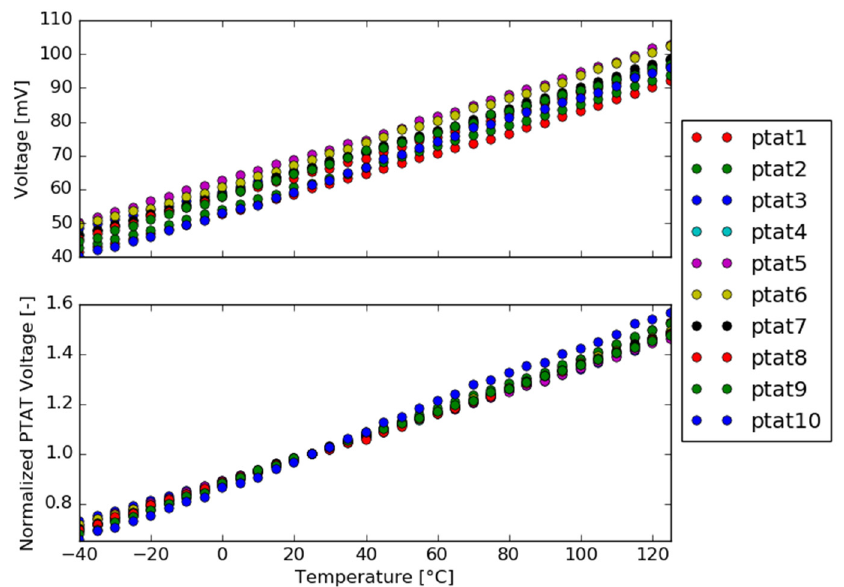
Figure 23. PTAT output voltage versus temperature.